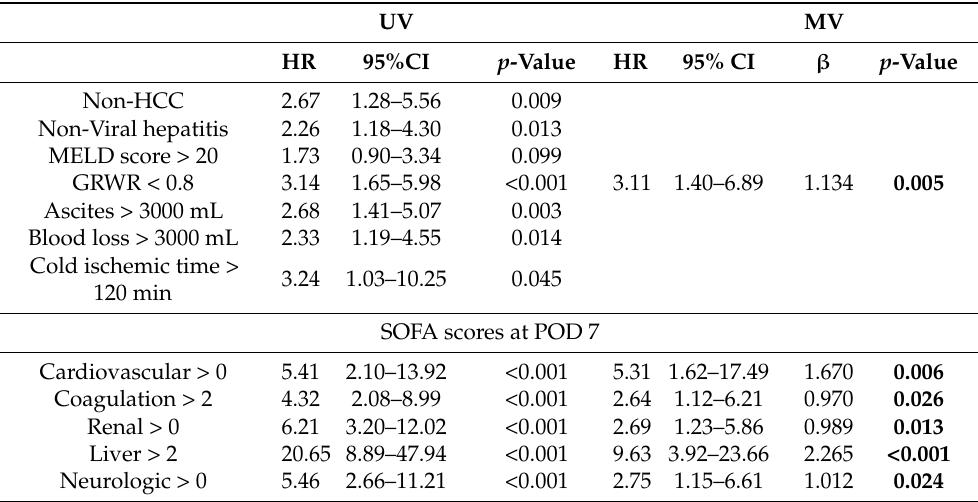
Table 3. Univariate and multivariate analyses to predict mortality within 3 months after transplant by logistic regression